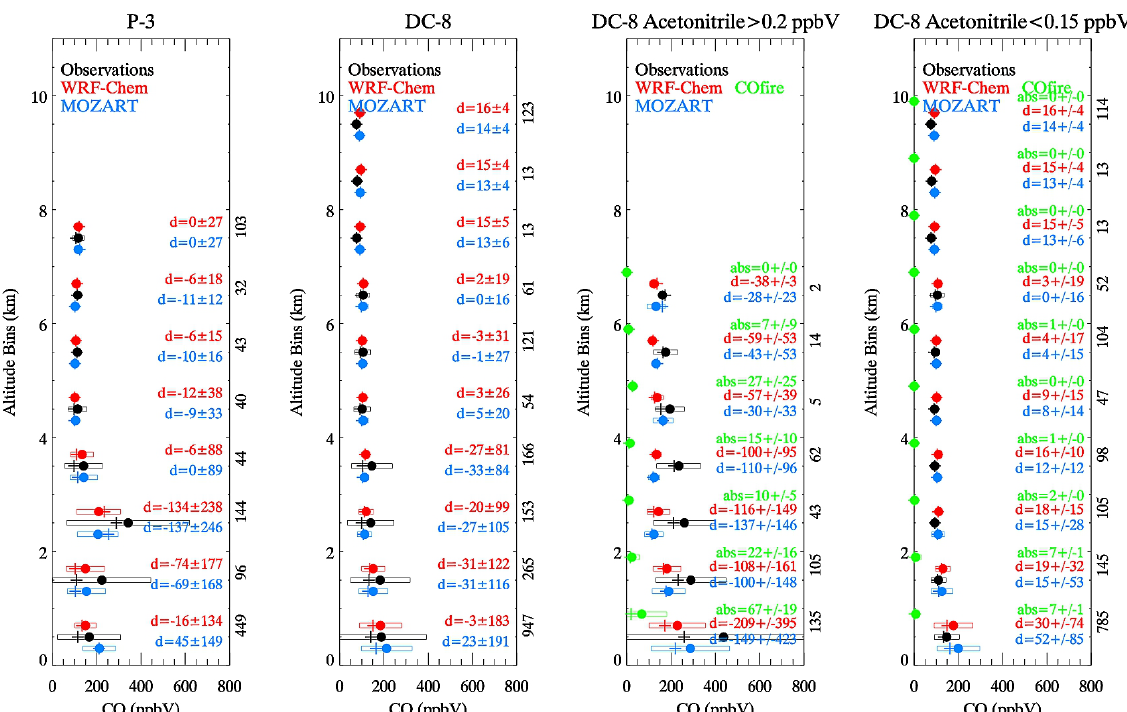
Fig. 1. Left two panels: mean (circles), median (plus signs) and standard deviation (bars) of observed (black), WRF-Chem (red) and MOZART-4 (blue) CO profiles for P-3 and DC-8 flights (excluding the boundary conditions leg on the 22 June flight). Mean difference ( d ) and standard deviation between model and observations is listed in each plot. The number of data points per altitude bin is specified next to the vertical axis. Right two panels: comparison for DC-8 observations, but separated into fire impacted and no fire impacted data sets based on observed acetonitrile mixing ratios. WRF-Chem fire tracer mixing ratios are shown in green and the absolute mean mixing ratios (abs) per altitude bin is listed in the